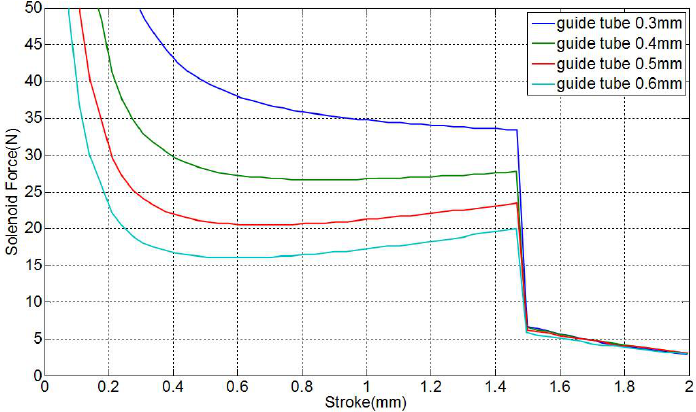
Figure 12. Simulation results for the guide tube.